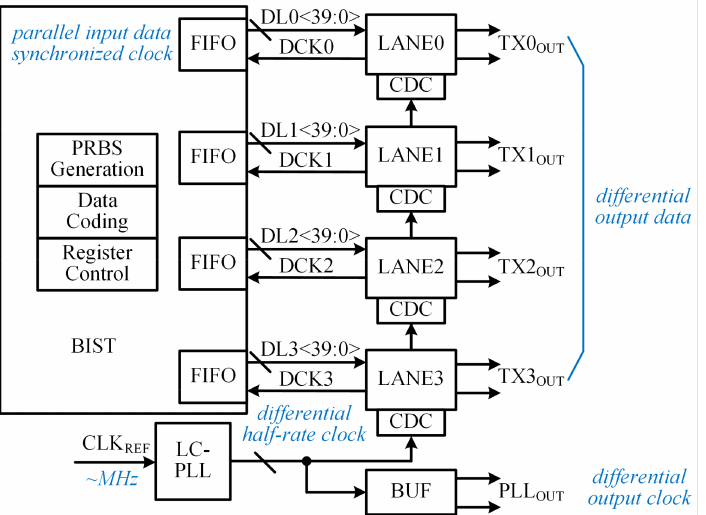
Figure 1. The top-level architecture of the proposed four-lane TX with on-chip